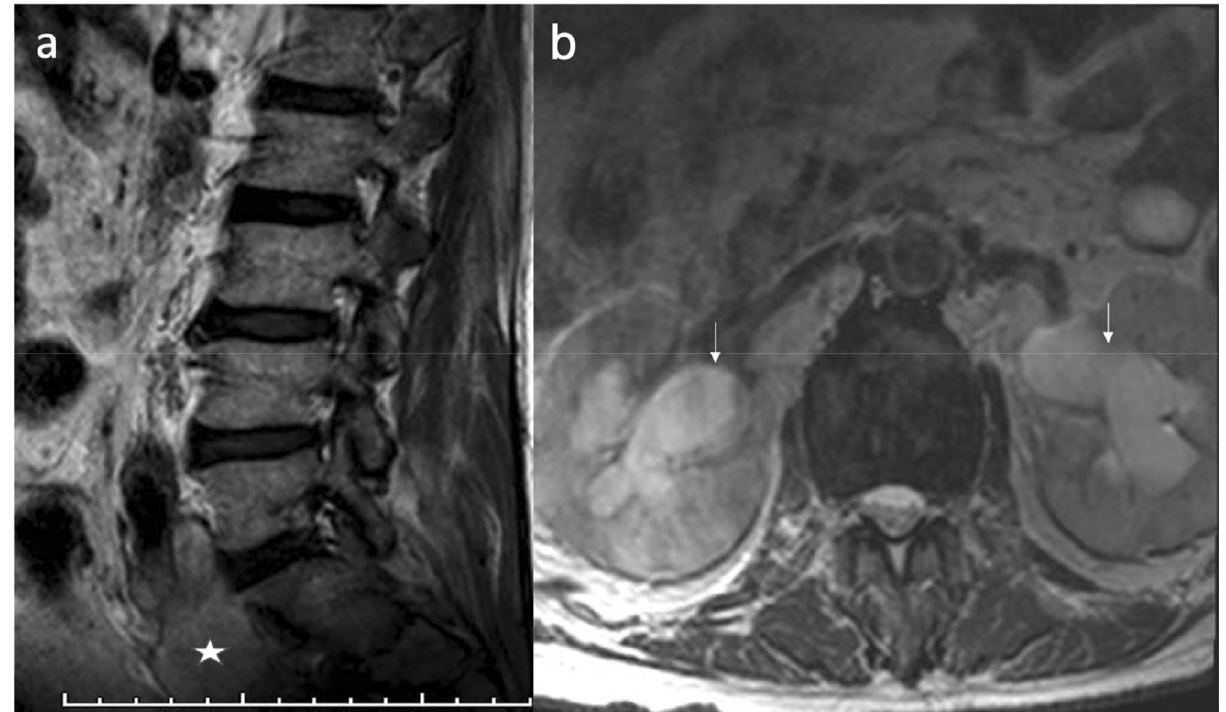
Figure 2. A 65-year-old male with metastatic bladder cancer. ( a ) Sagittal T2 weighted image showing pathological lymph nodes along the left iliac vessels (asterisk). ( b ) Axial T2 weighted image showing bilateral hydronephrotic changes (white